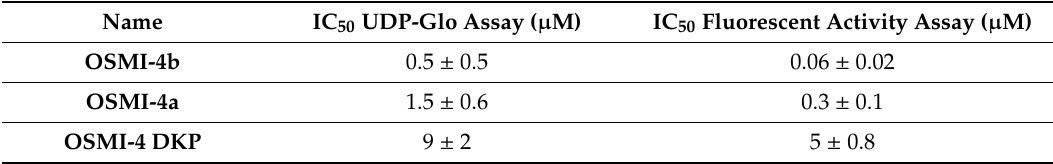
Table 2. IC 50 of the three OGT inhibitors measured with UDP-Glo ™ Assay (Promega) and fluorescent activity assay. Results are expressed as mean ±